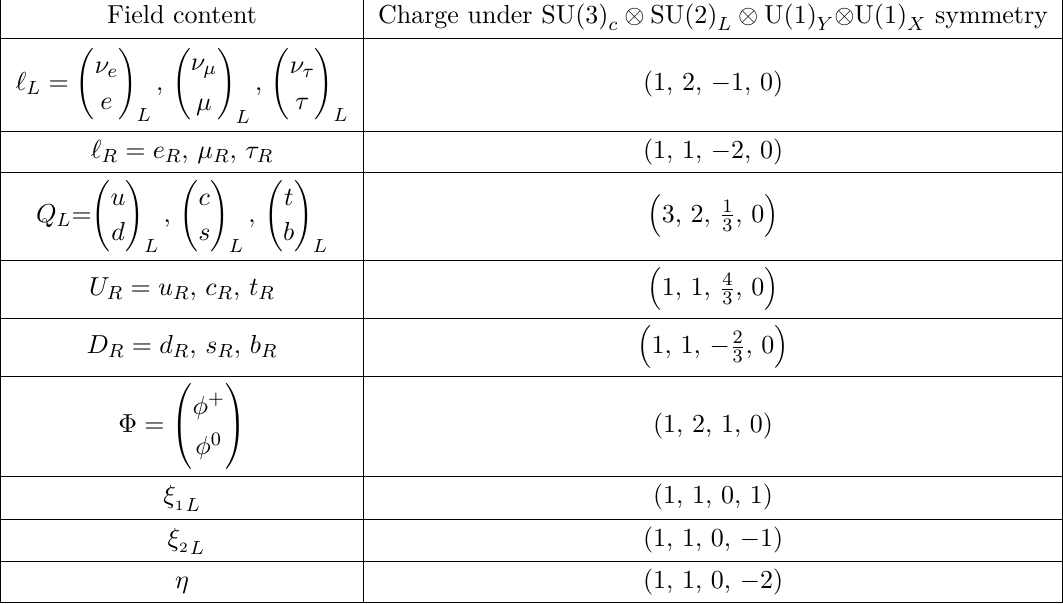
Table 1 . Field contents of our model and their charges under SU(3) L DM-Yukawa